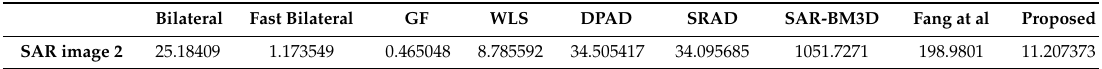
Table 14. Computational complexity results of the despeckling methods for the real SAR image 2 (1323 × 803).